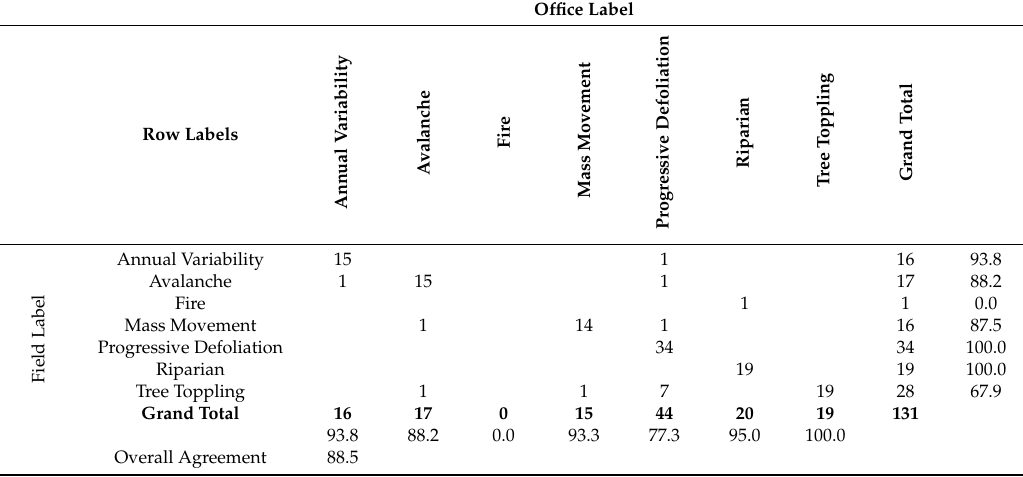
Table 2. Agreement matrix comparing primary labels assigned in office and field for the random sample